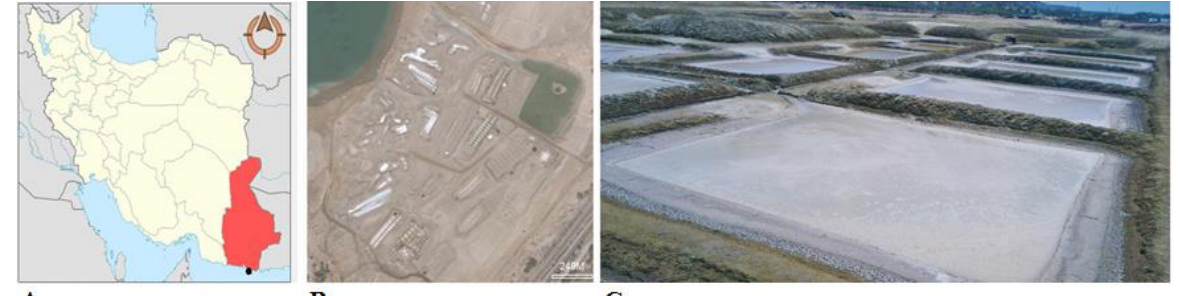
Fig. 1. Location map of the Tis solar saltern and sampling pond used in the diversity study. A=Solar ponds located in Sistan and Baluchestan province; B= Aerial image of salt ponds; C= crystallizer